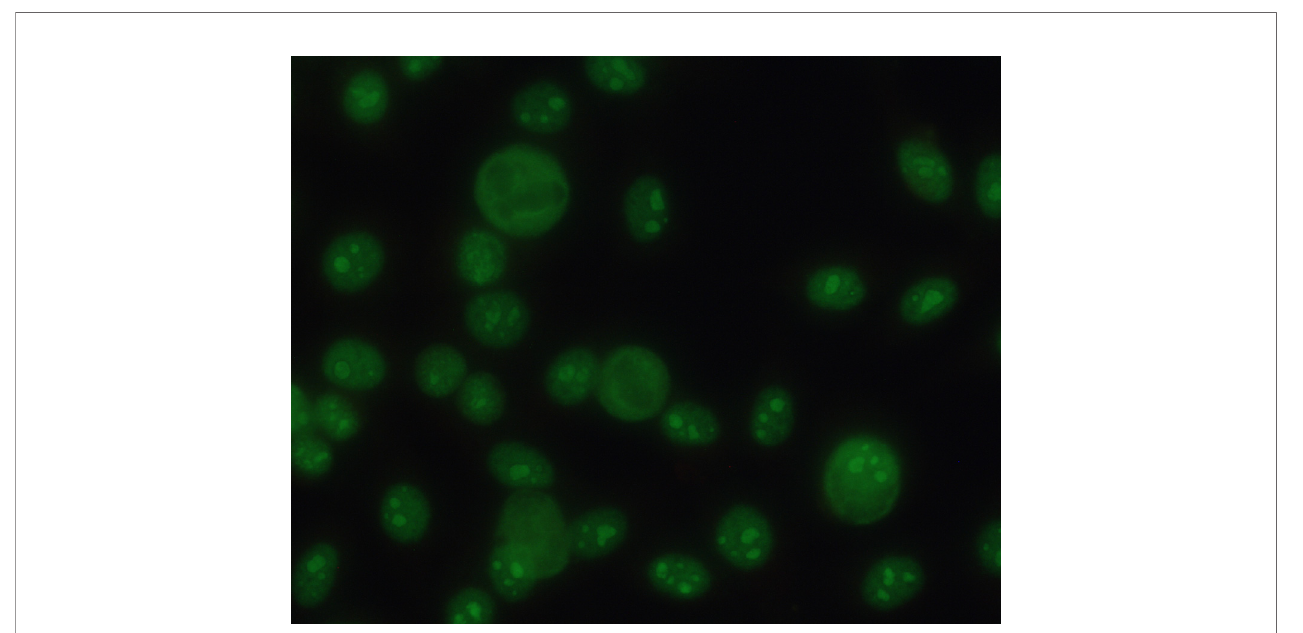
FIGURE 1 | Indirect immuno fl uorescence assay on HEp-2 cells shows the following pattern: Homogeneous nucleolar/AC-8 (titer 1,600). According to ANA pattern classi fi cation Chan et al.